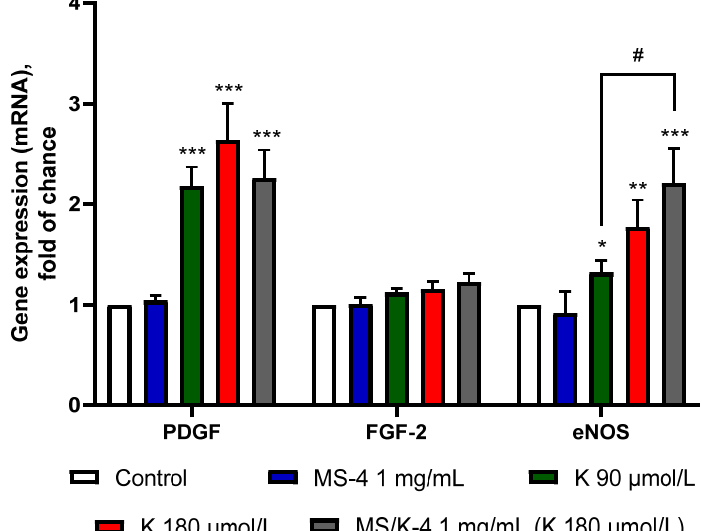
Figure 12. MS/K-4 induced the expression of pro-angiogenic genes in human endothelial cells. HMEC-1 was treated with MS/K-4, free LYS, or MS-4 for 24 h at the concentrations indicated. The total RNA was then extracted from cells, and the mRNA levels of PDGF and FGF-2 were measured via qPCR using specific primers and normalized to GAPDH RNA. Data (means ± S.D.; n = 3) were expressed as fold induction over the basal (untreated) control. * p < 0.05 versus basal (untreated control); ** p < 0.01 vs. basal (untreated control); *** p < 0.001 vs. basal (untreated) control; # p < 0.05 between joined